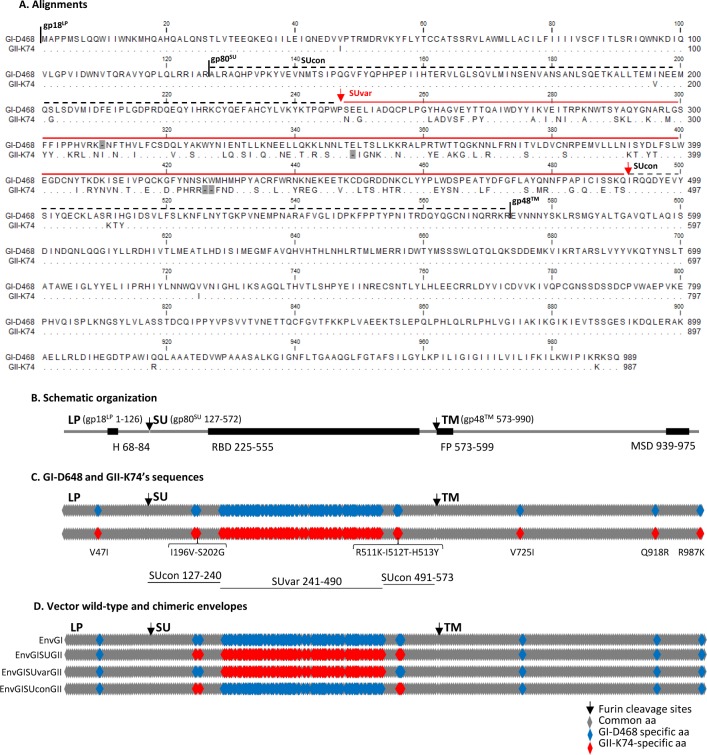
Gorilla SFV envelope proteins: alignment, schematic organization, localization of sequence variations, and design of the chimeric proteins used for epitope mapping.A. Env sequences from GI-D468 and GII-K74 strains were aligned using CLC Mainworkbench software. Identical residues are indicated with dots. The three subdomains (gp18LP, leader peptide; gp80SU, surface protein; gp48TM, transmembrane protein) are indicated above the sequences. The lines indicate the localization of the variable (SUvar, red) and conserved (SUcon, black) regions, respectively. B. Schematic organization of the SFV Env protein. Amino acid positions are those of the GI-D468 strain. Furin cleavage sites (arrows) and envelope subunits are indicated above the grey line. Major functional or structural domains are shown by the bold line (H, hydrophobic region; RBD, receptor binding domain; FP, fusion peptide; MSD, membrane spanning domain). C. Schematic representations of GI-D468 and GII-K74 Env sequences. Grey symbols represent identical amino acids and blue/red symbols GI/GII-specific amino acids, respectively. Sequences from point mutations outside SUvar are indicated below the diagram, as well as the SUcon and SUvar regions. The color code is not to scale in the SUvar region: amino acid identity is 58% in this region. D. Schematic representation of the Env proteins used to produce the vectors and map the neutralization epitopes. Full-length GI-D468 was used as the wild-type backbone, in which the SU, SUvar, and SUcon coding sequences from GII-K74 were inserted. The same color code is used as in panel B.